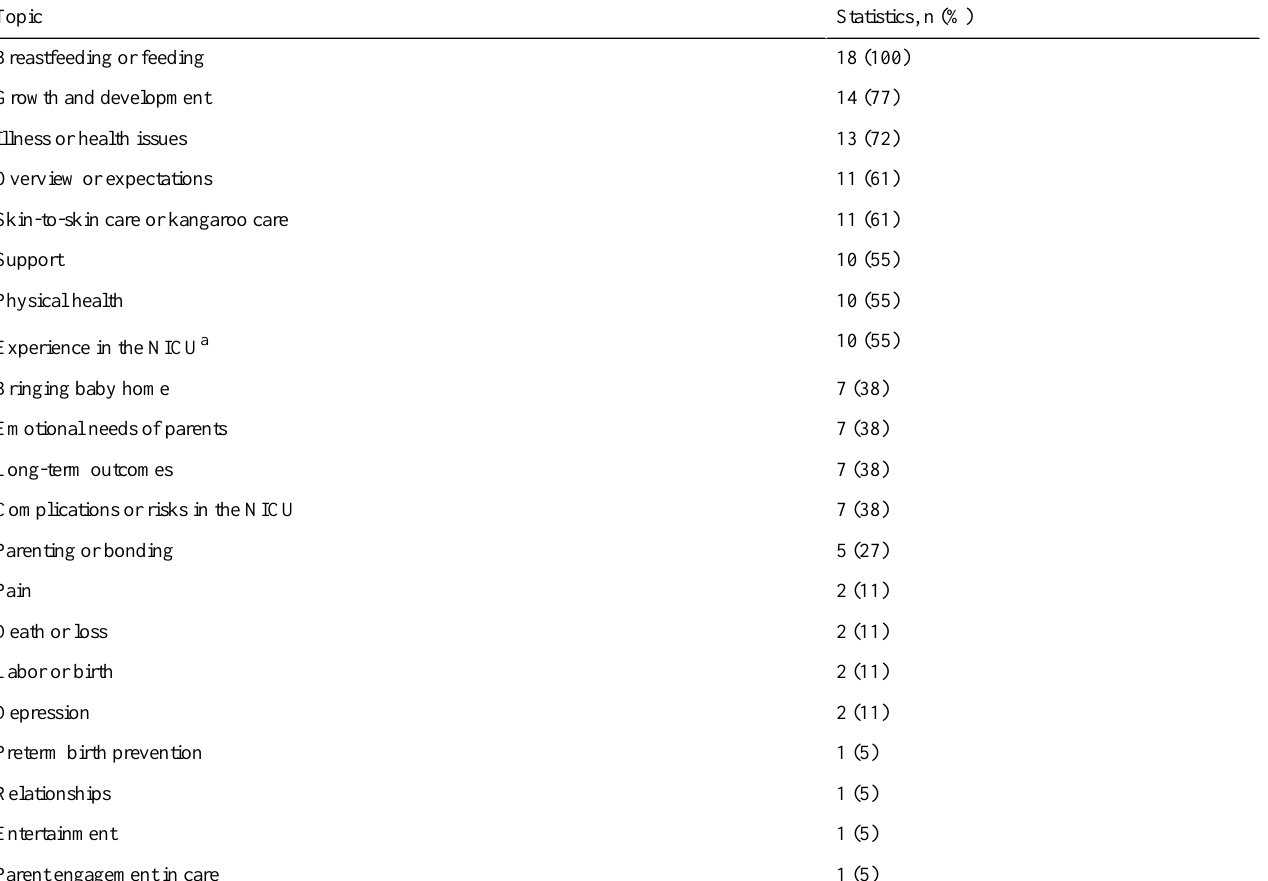
Table 3. Full list of topics covered (N=18).